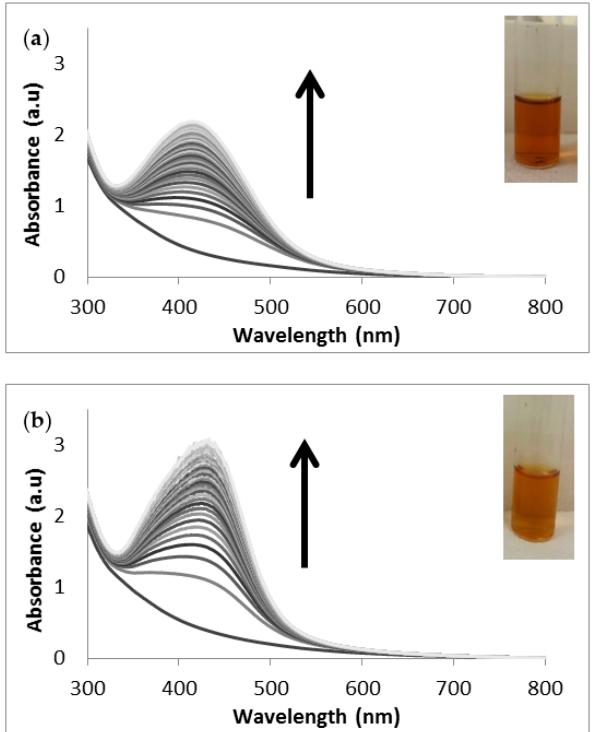
Figure 2. UV-Vis absorption spectra of ( a ) the AC-AgNPs and ( b ) the AR-AgNPs from time 0 to 18 h. Inset: Photograph of the colour of the solution after 18 h (in water). AC: Aqueous extract subjected to organic solvent partitioning. AR: simple aqueous extraction.